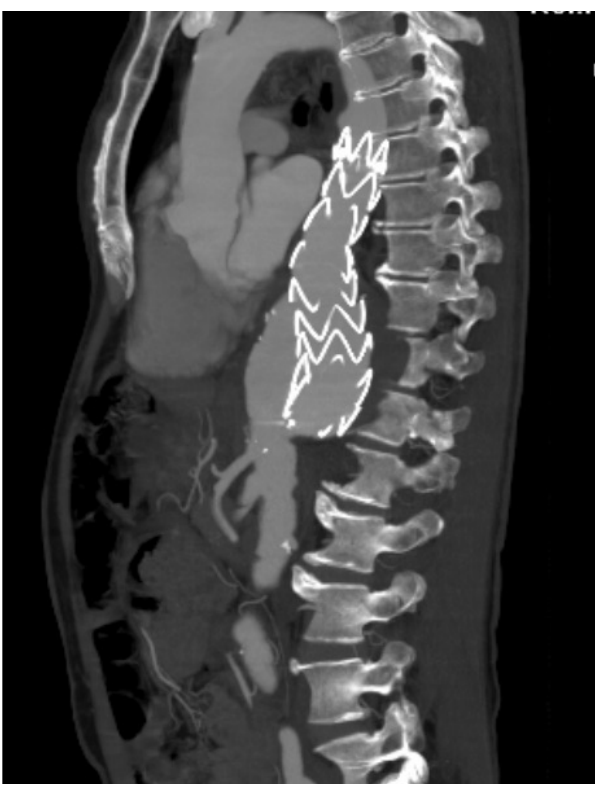
Fig. 4 - Preoperative computed tomography angiography of increasing diameter of aneurysm and Type 1b endoleak in the distal part of the stent graft in the patient with history of thoracic endovascular aneurysm repair.